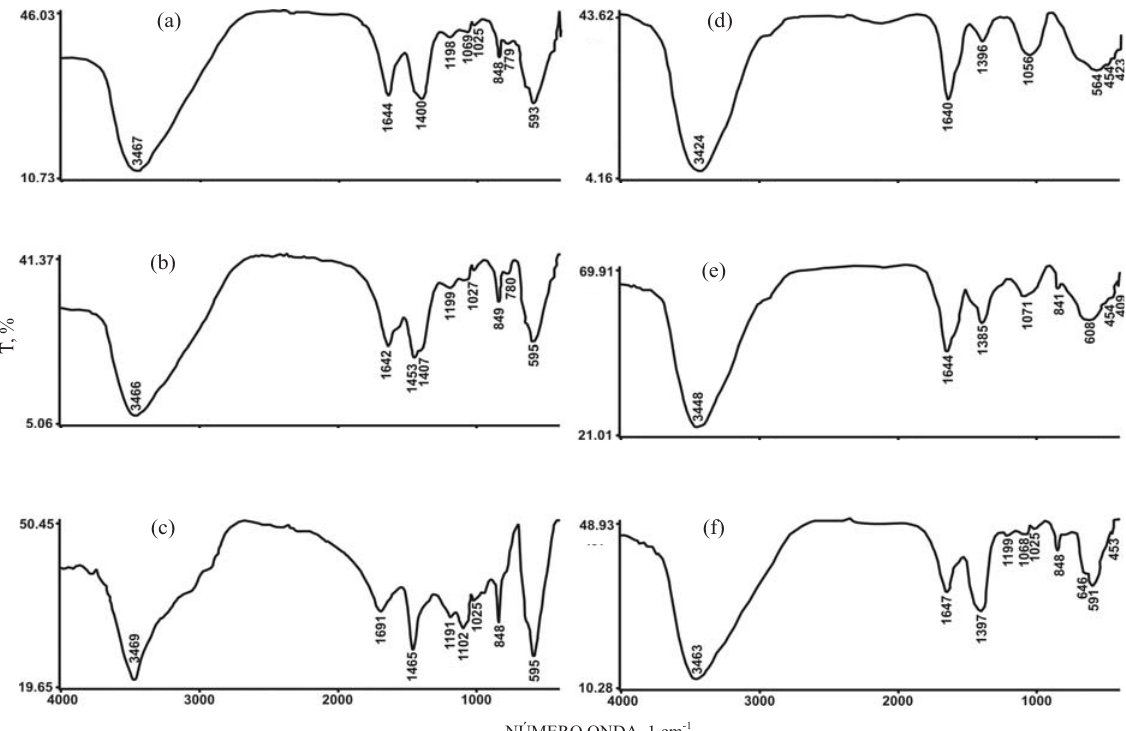
Figura 1. Espectros de infravermelho dos ácidos fúlvicos extraídos das amostras de solos coletadas em área de extração de argila com cobertura de Brachiaria mutica nas profundidades de 0–10 cm (a), 10–20 cm (b), 20–30 cm (c) e com Acacia mangium nas profundidades de 0–10 cm (d), 10–20 cm (e), 20–30 cm